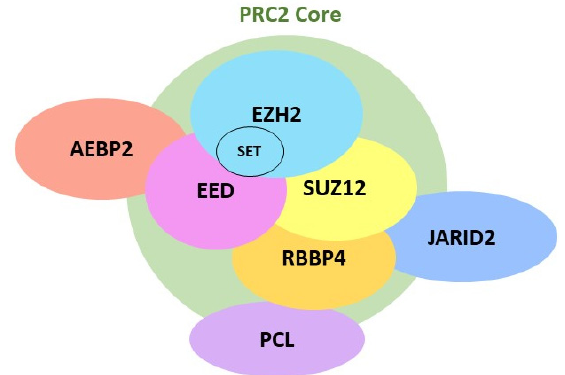
Figure 1. Assembly of PRC2 core and non-core subunits. EZH2 contains the SET domain, which exerts methyltransferase activity on the PRC2 complex. EED: embryonic ectoderm development; EZH2: enhancer of zeste homolog 2; RBBP4: retinoblastoma binding protein 4, SUZ12: suppressor of zeste 12 homolog; SET: Su(var)3-9, enhancer-of-zeste, and trithorax domain; AEBP2: adipocyte enhancer-binding protein 2; PCL: polycomb-like proteins; JARID2: jimonji, AT-rich interactive domain 2.